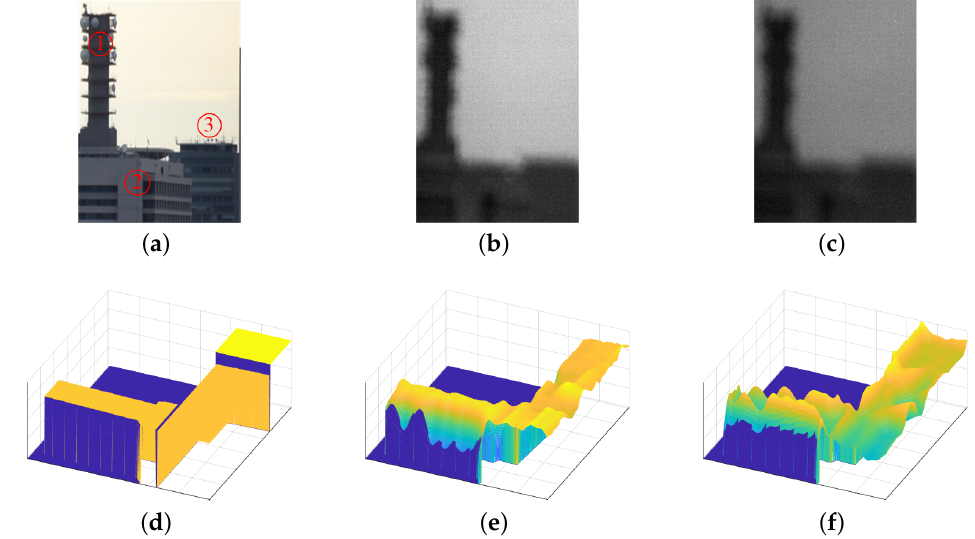
Figure 12. Estimated distance of scene 5 using a bispectral light extinction in bad weather. ( a ) RGB image. ( b ) Image at 905 nm. ( c ) Image at 980 nm. ( d ) Groundtruth. ( e ) Our result. ( f ) Result of comparison method.